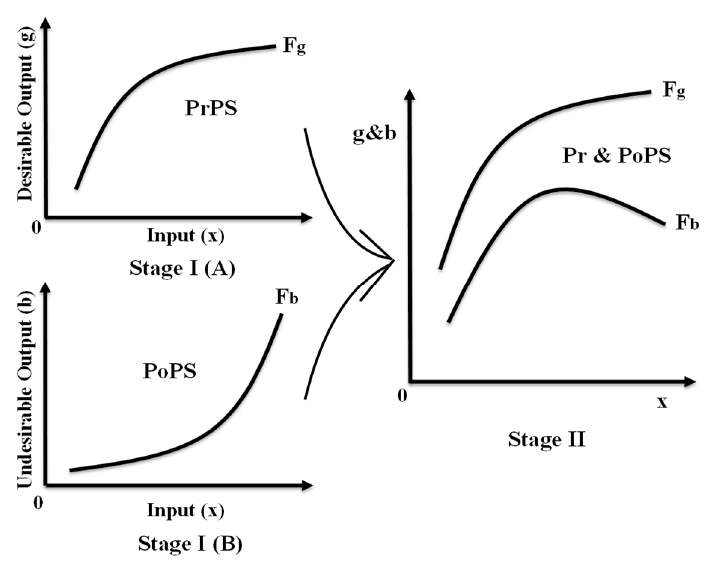
Figure 3. Unification between G and B. (a) The F stands for an e ffi ciency frontier. The subscript indicates g or b . (b) PrPS, PoPS and Pr&PoPS indicate Production Possibility Set, Pollution Possibility Set, and Production and Pollution Possibility Set. (c) This study considers that DMUs in Pr&PoPS maintain their